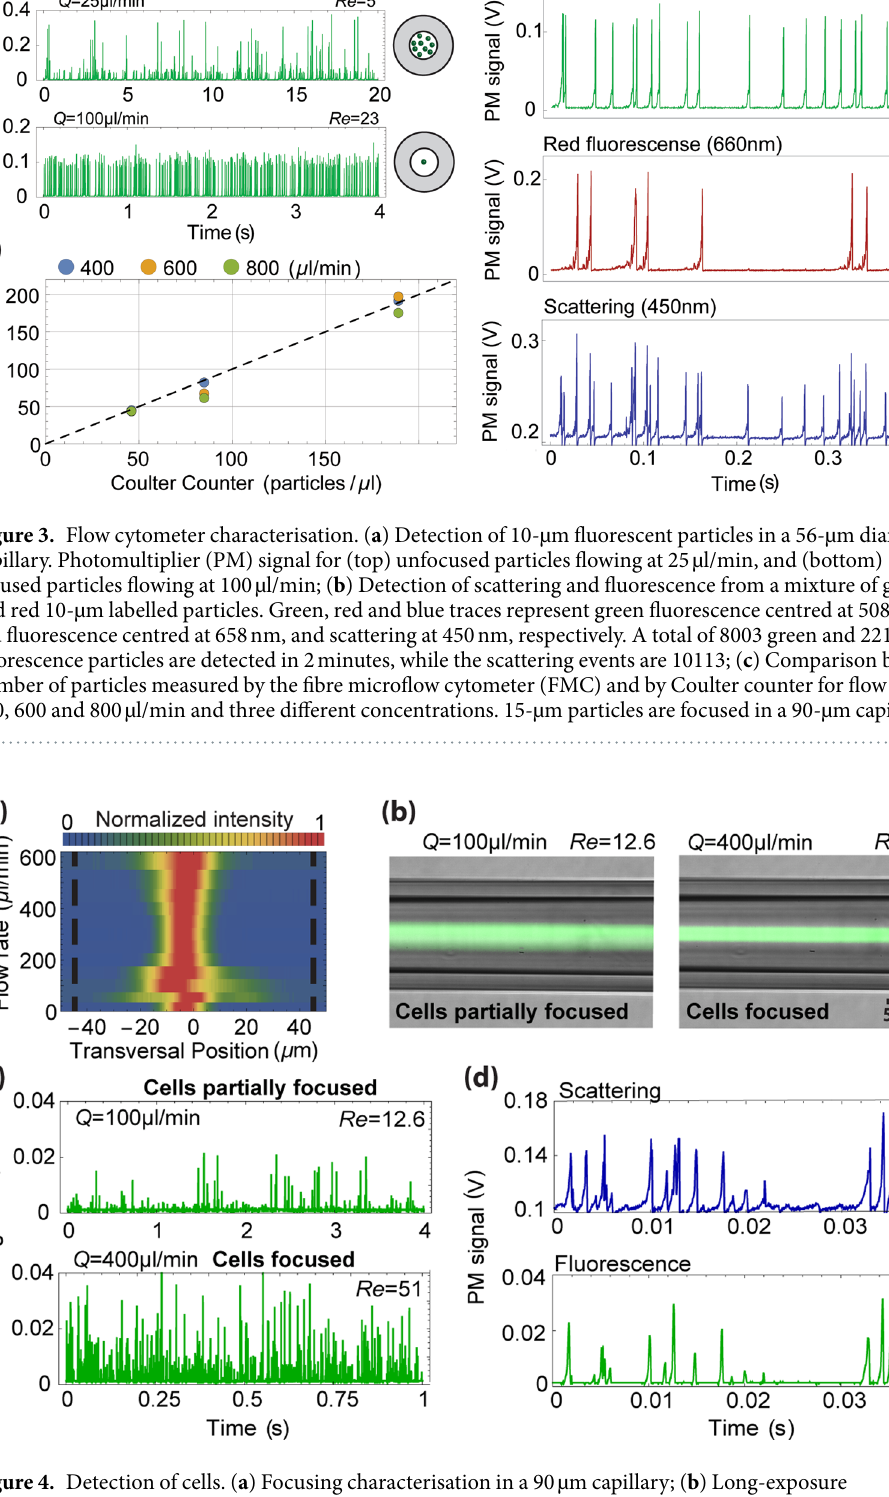
Figure 4. Detection of cells. ( a ) Focusing characterisation in a 90 µ m capillary; ( b ) Long-exposure fluorescence microscope images of partially focused (left) and focused regimes (right); ( c ) Fluorescence signals corresponding to the images in ( b ); ( d ) Example of scattering and fluorescence over a 0.04 s interval. Data was obtained from a 1 minute recording with a total of 35484 fluorescence and 46101 scattering